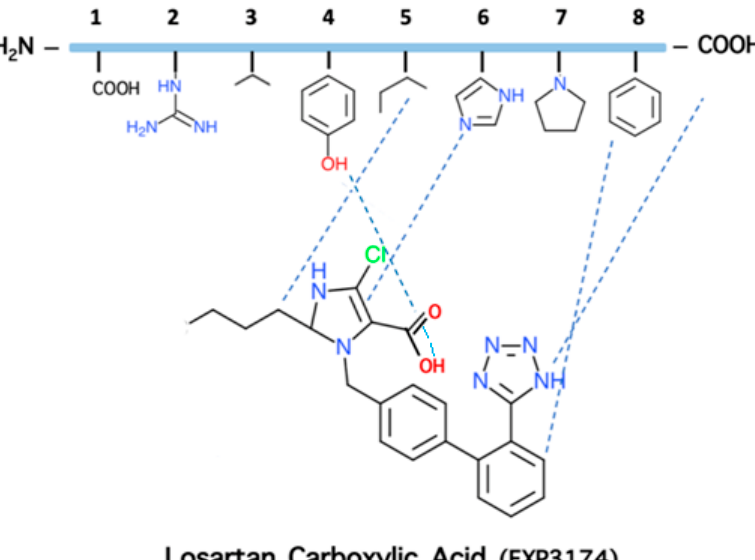
Figure 9. Correlation of pharmacophoric side chains of angiotensin II with essential groups in losartan carboxylic acid (EXP 3174).